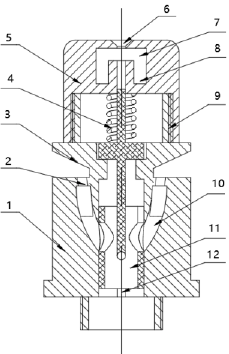
Figure 1. Schematic of the new type ofwater–pesticide integrated sprinkler structure. 1. Spinkler body; 2. Deflection hole; 3. Refractive cone; 4. Compression spring; 5. Spinkler cap; 6. Spray nozzle; 7. Rotary acceleration chamber; 8. Diversion chute; 9. Thread; 10. Runner; 11. Valve spool; 12. Square slot.